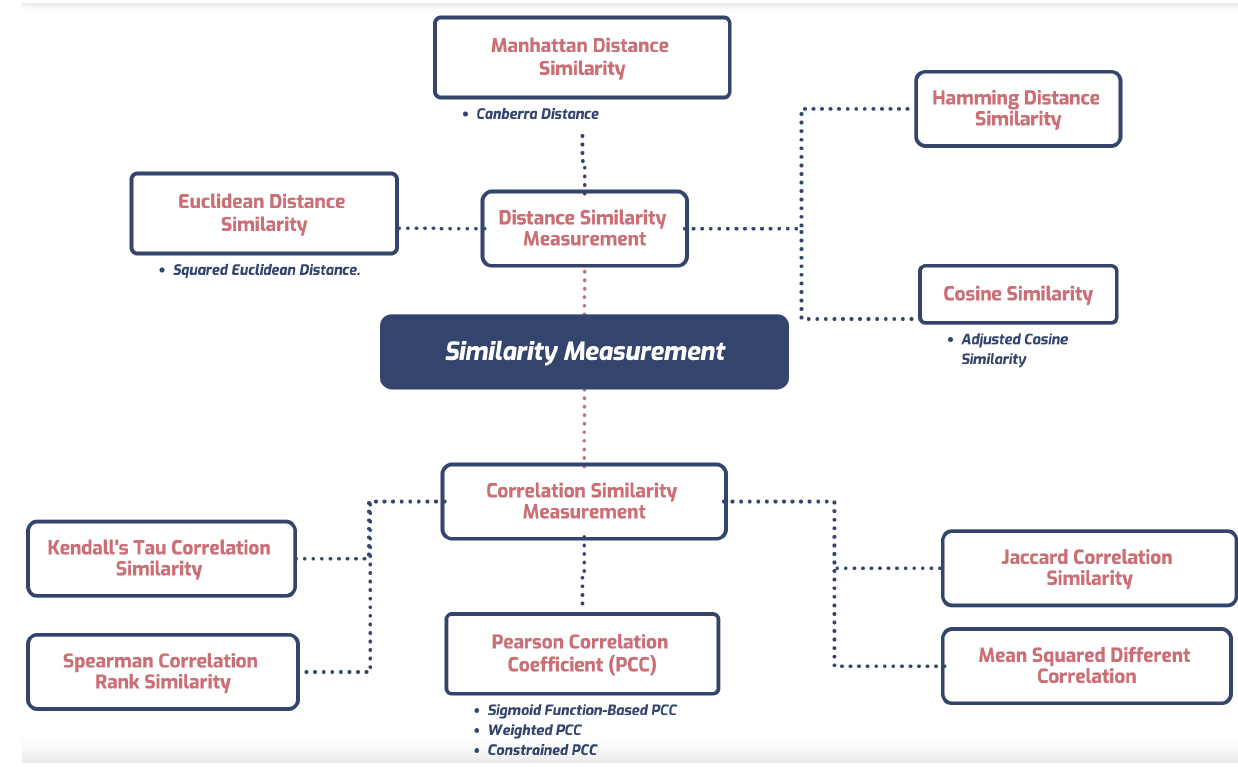
Figure 1. Similarity metrics